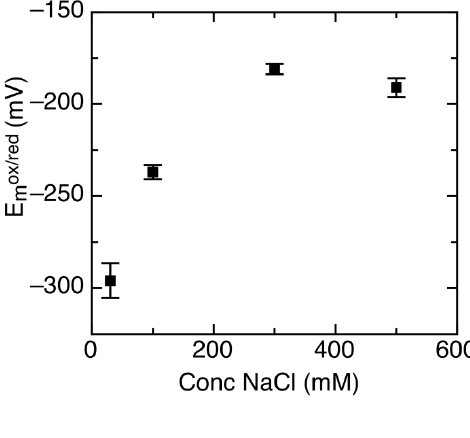
) of AidB at various NaCl m